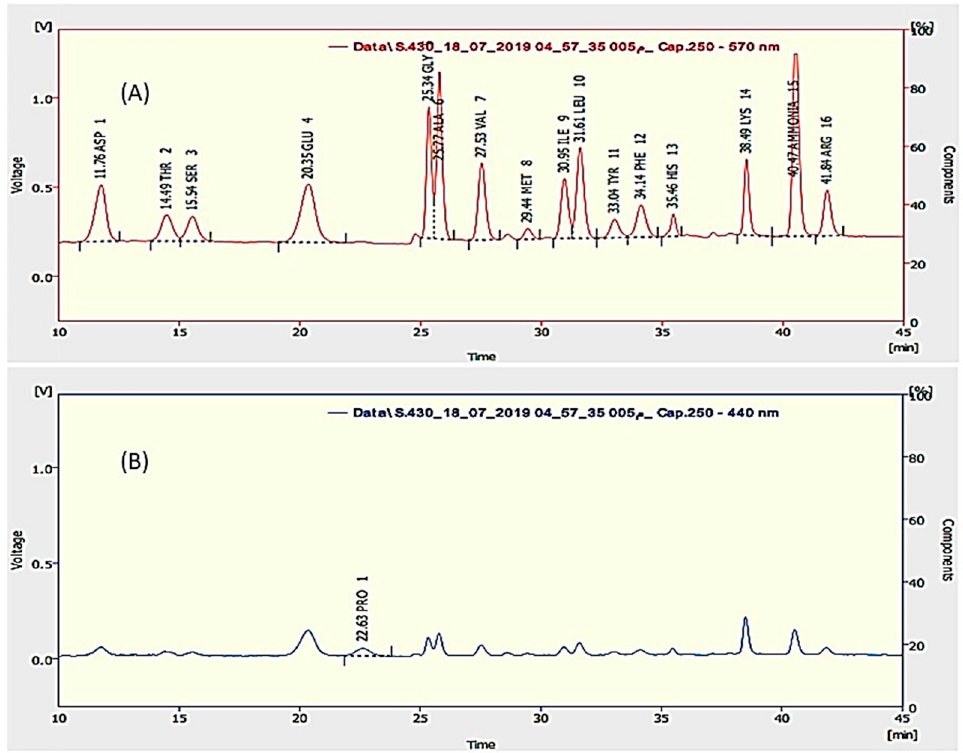
Figure 2. HPLC chromatogram of amino acids in SP at λ 570 nm ( A ) and for proline at λ 440 nm ( B ) .